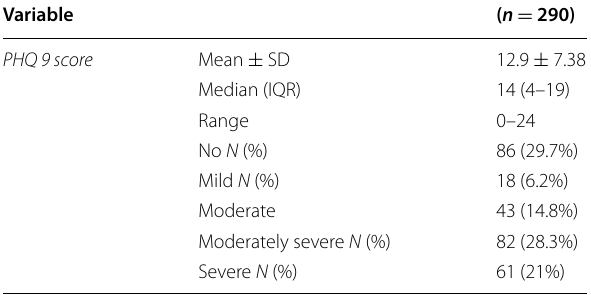
Table 3 Frequency of depression among the studied